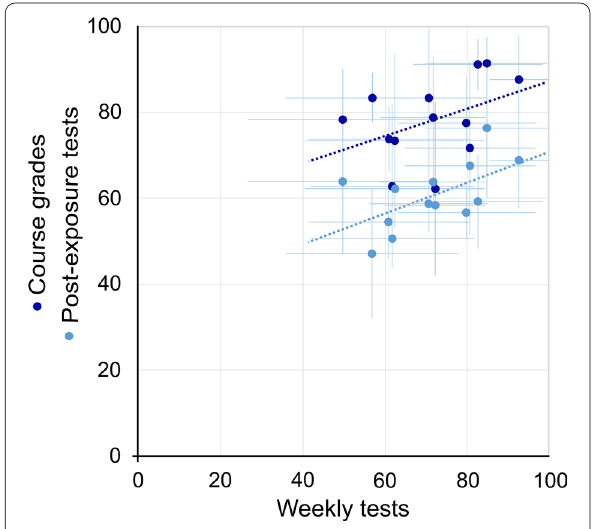
Fig. 4 Graph showing the correlation of the results obtained by each team in the weekly game tests with the results obtained in the post‑exposure tests (light blue points; Pearson’s coefficient and with the course grades (dark blue points; Pearson’s coefficient 0.425). The data are the average scores obtained by = teams, expressed as a percentage. Error bars represent the standard